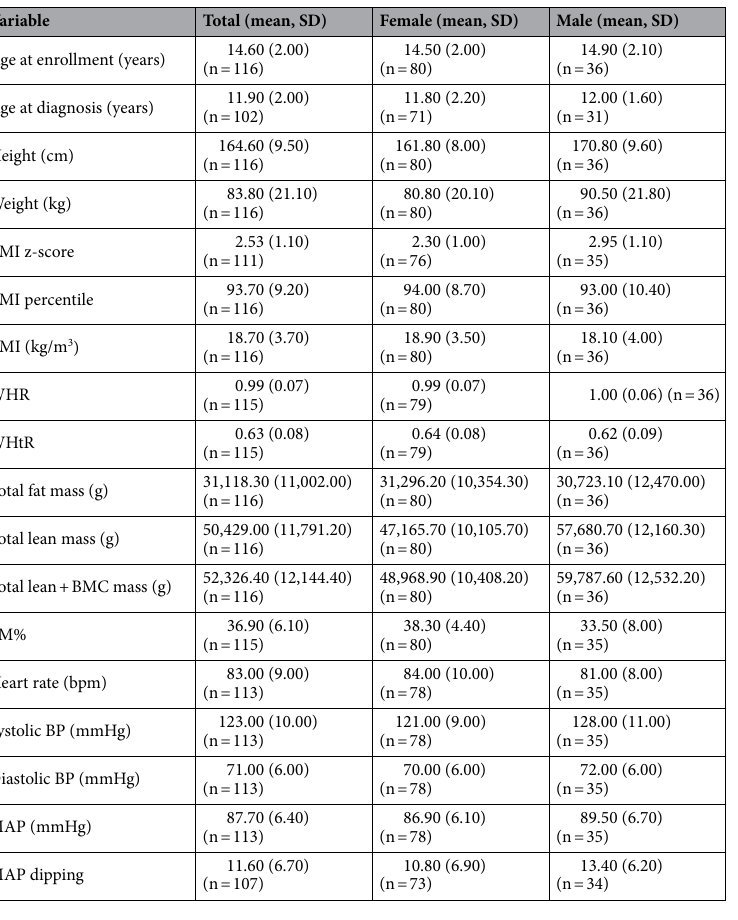
Table 1. Participants’ descriptive characteristics. BMI body mass index, TMI tri-ponderal mass index, WHR waist-to-hip ratio, WHtR waist-to-height ratio, BMC bone mineral content, FM% fat mass percentage,